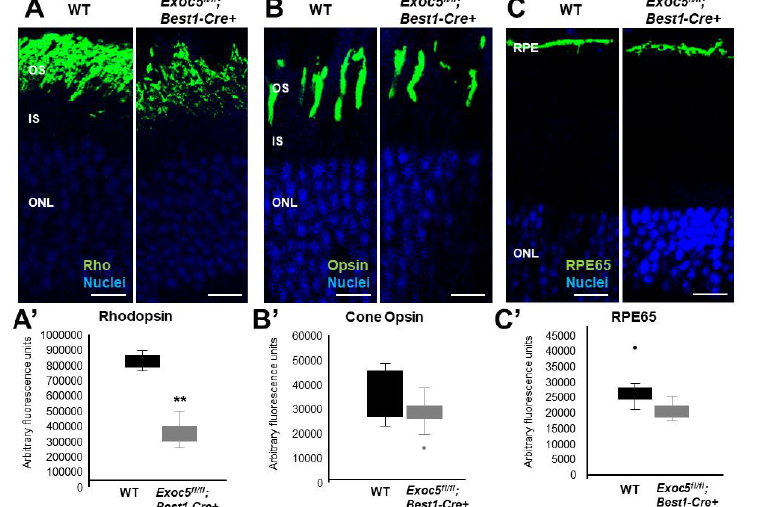
Figure 6. Immunohistochemical analysis of rod and cone photoreceptors in wild-type and conditional Exoc5 knockout mice at 20 weeks of age. Levels and localization of rhodopsin (green, Rho, ( A )), red/green cone opsins (green, R/G Opsin, ( B )), and RPE65 (green, RPE65, ( C )) were assessed using immunohistochemistry in retinal sections of 20-weeks-old mice to identify alterations in rod and cone outer segments, as well as retinal pigment epithelium (RPE). Only moderate differences in staining were observed. Scale bars = 50 µ m ( A – C ). Image J was used to quantify rhodopsin ( A’ ) and cone opsin ( B’ ) fluorescence in photoreceptors, and RPE65 ( C’ ) in RPE of WT and Exoc5fl/fl;Best1-Cre + mice. OS, outer segments; IS, inner segments; ONL, outer nuclear layer, INL, inner nuclear layer; RPE, retinal pigmented epithelium. ** p < 0.05 (WT vs. Exoc5fl/fl;Best1-Cre + mutants). Int. J. Mol. Sci. 2021 , 22 , x FOR PEER REVIEW